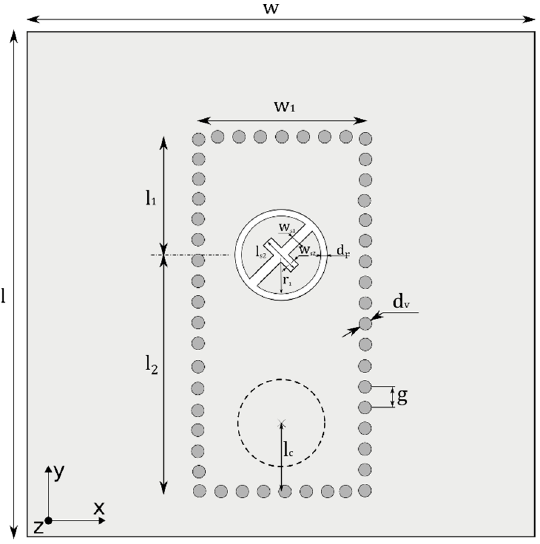
Figure 1. Layout of the designed textile-integrated slot antenna.